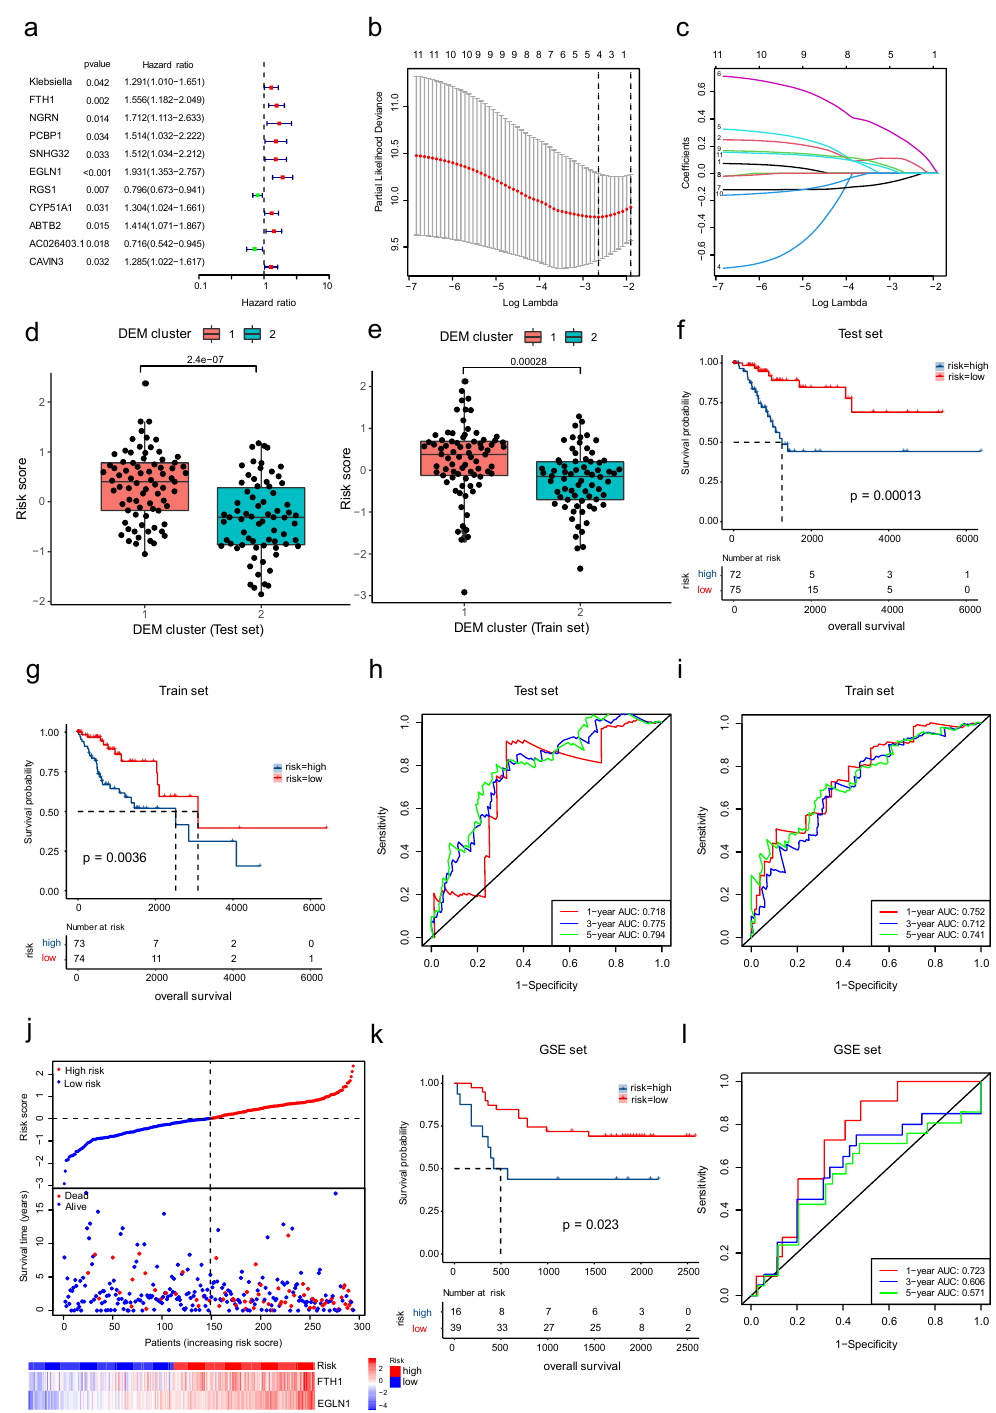
Figure 7. The construction and validation of a prognostic risk score model. ( a ) Univariate Cox regression in the training set to screen for survival-related variables, risk factors for survival are on the right side of the dotted line, and protective variables are on the left.; ( b ) cross-validation curves of LASSO regression; ( c ) path coefficient plots of LASSO regression; ( d , e ) comparison of prognostic risk scores for different DEM clusters; ( f , g ) K–M curves for patients with different risk score classes; ( h , i ) ROC curves for predictive validity of risk score models for 1-year, 3-year, and 5-year OS rates; ( j ) scatter plots showing survival status, risk score distribution, and heatmaps of expressions for two key variables for all patients; ( k ) prognostic K–M curves for patients with different risk score classes in the GSE52903 cohort; and ( l ) ROC curves for predictive validity of the risk score model in the GSE52903